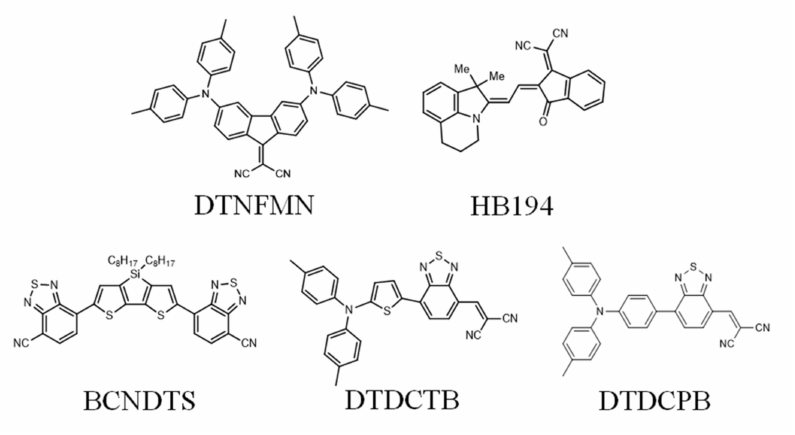
Figure 1. Chemical structure of intramolecular charge transfer (CT) molecules used in this